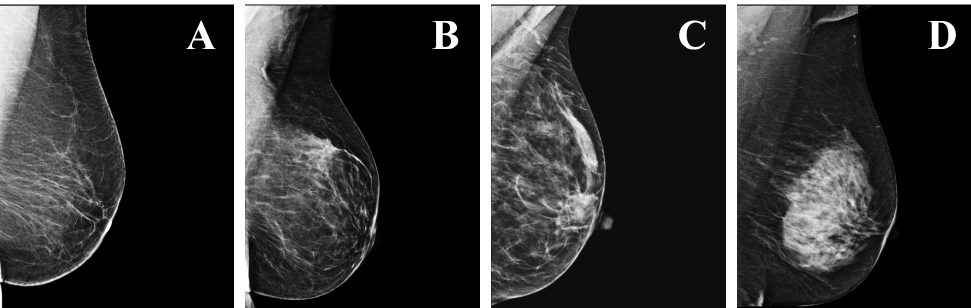
Figure 1. Examples of the four levels of density in mammograms, as defined by the BI-RADS: ( A ) a—almost entirely fatty; ( B ) b—scattered areas of fibroglandular density; ( C ) c—heterogeneously dense; ( D ) d—extremely